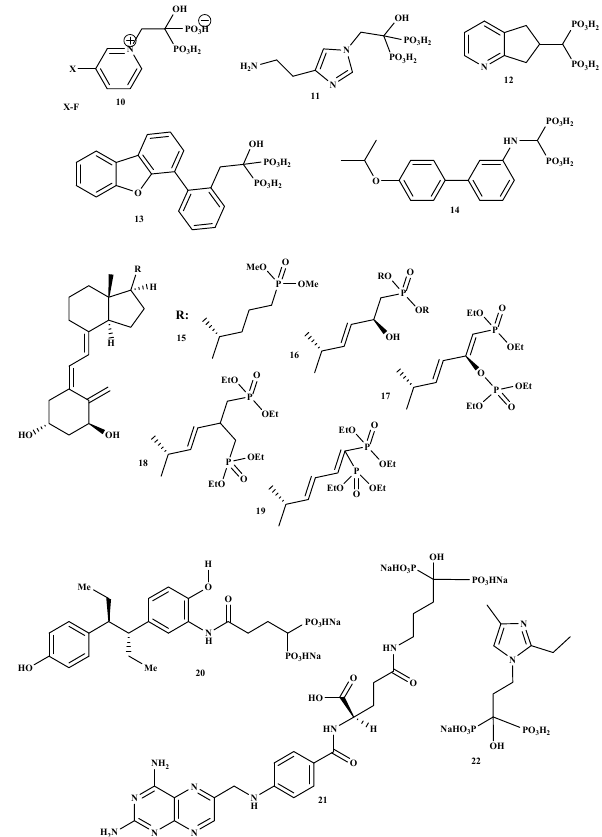
Figure 2. Structures of BP ‐ conjugates 10–22 , potential compounds reported for the treatment of osteoporosis. 3. Bone Cancer Bones are crucial in the body for movement and structure, mineral storage, protection of organs, and in blood cell production, provides a site as bone marrow houses hemato ‐ poietic cells for the production of leukocytes, platelets, and red blood cells [37]. Bones are essential for storing phosphorus and calcium in the body because of their hydroxyapatite crystal structure. Bones continuously undergo cycling of resorption and deposition of the osteoid and hydroxyapatite matrix. Bone releases minerals via resorption by the osteo ‐ clasts, the cells accountable for separating bone matrix, whereas osteoblasts develop novel bone through emitting chondroitin, osteocalcin, and collagen to formulate osteoid [37].